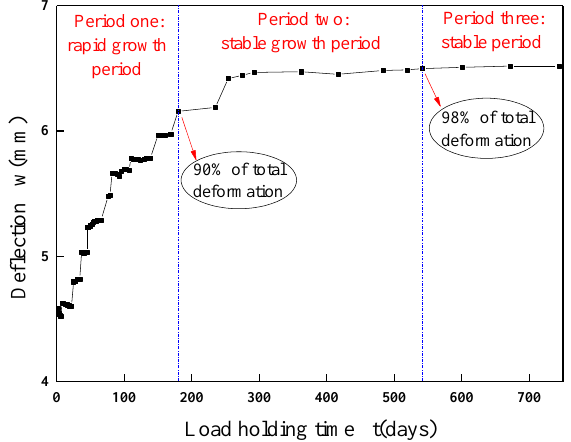
Figure 7. Time-dependent behavior development of D100/0-H.